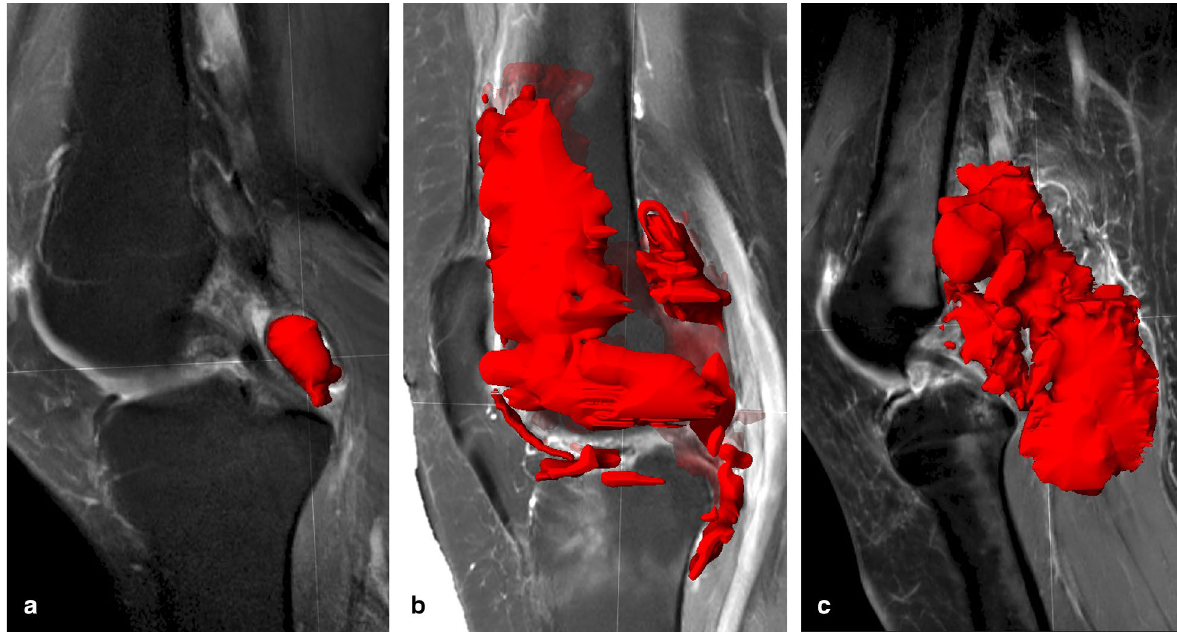
Fig. 8 Volumetric segmentations of D-TGCT performed with Brainlab software on sagittal T1 SPIR-weighted sequences post gadolinium. a Tumour is segmented in the PCL recess (volume shown in red). Volume: 3.8 cm 3 . b Tumour segmentation in anterior, middle and posterior compartments. Volume: 86.2 cm 3 . c Tumour segmentation of a case with marked posterior disease, present in the PCL recess, subgastrocnemius synovial recesses, Baker’s cyst, and extending extra-articular in the popliteal fossa. Volume: 91.9 cm